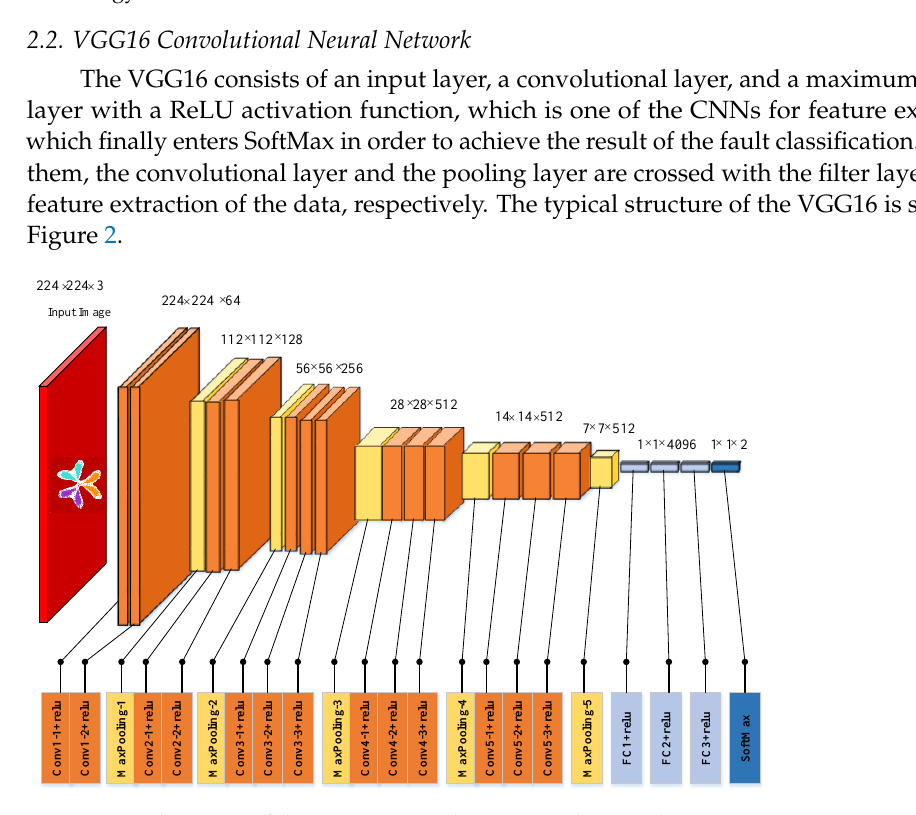
Figure 1. SDP technology conversion schematic diagram. ( a ) Time-domain vibration signal; ( b ) SDP technology conversion.